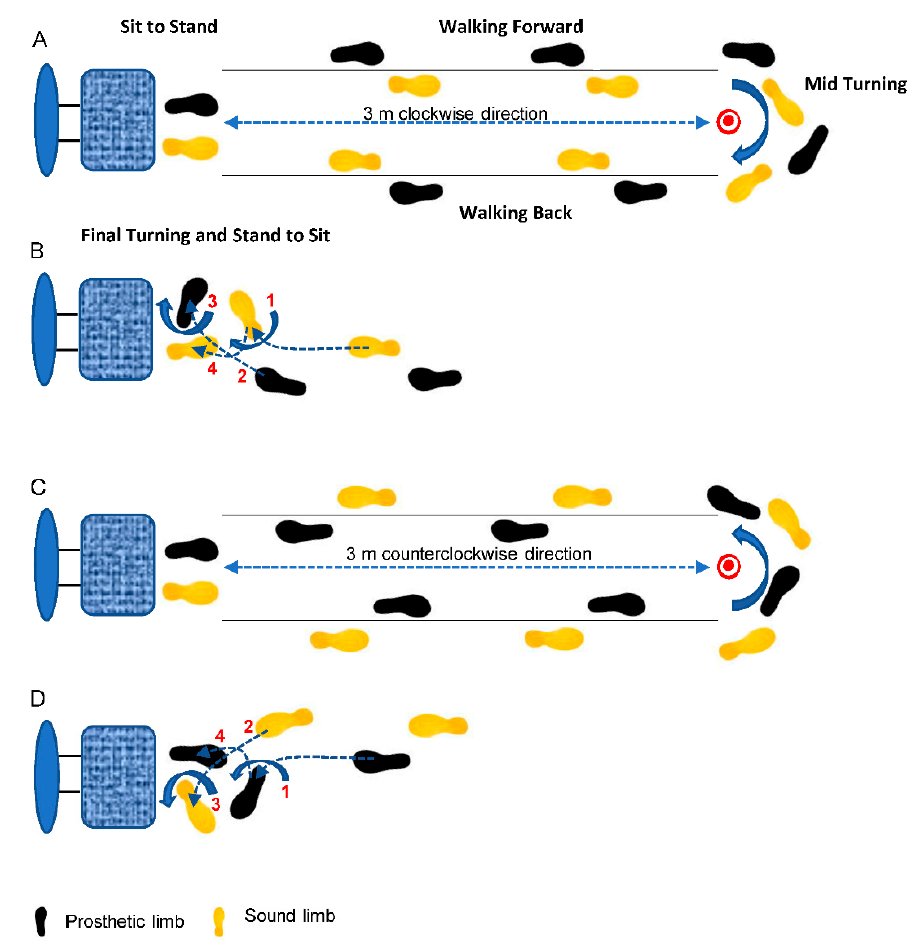
Figure 1. Top view of typical path of 3-m long for the TUG test. The test was performed in clockwise ( A , B ) and counterclockwise ( C , D ) directions. The single subcomponents are indicated in the panels ( A , B ). Four basic phases are performed to accomplish the final turning, before sitting down ( B , D ): (1) the body rotated of about 90° around the inner limb, (2) allowing the swing of the outer limb; (3) the body rotated of another 90° around the outer limb, (4) allowing the swing of the inner limb and the completion of 180° body rotation.